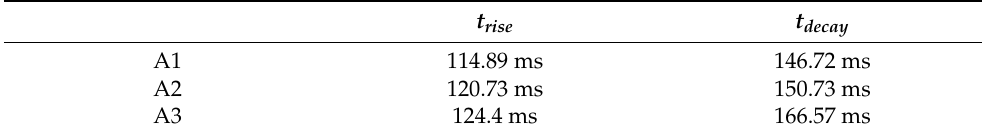
Table 5. Time constants of the A1 film Au/SRO/Si